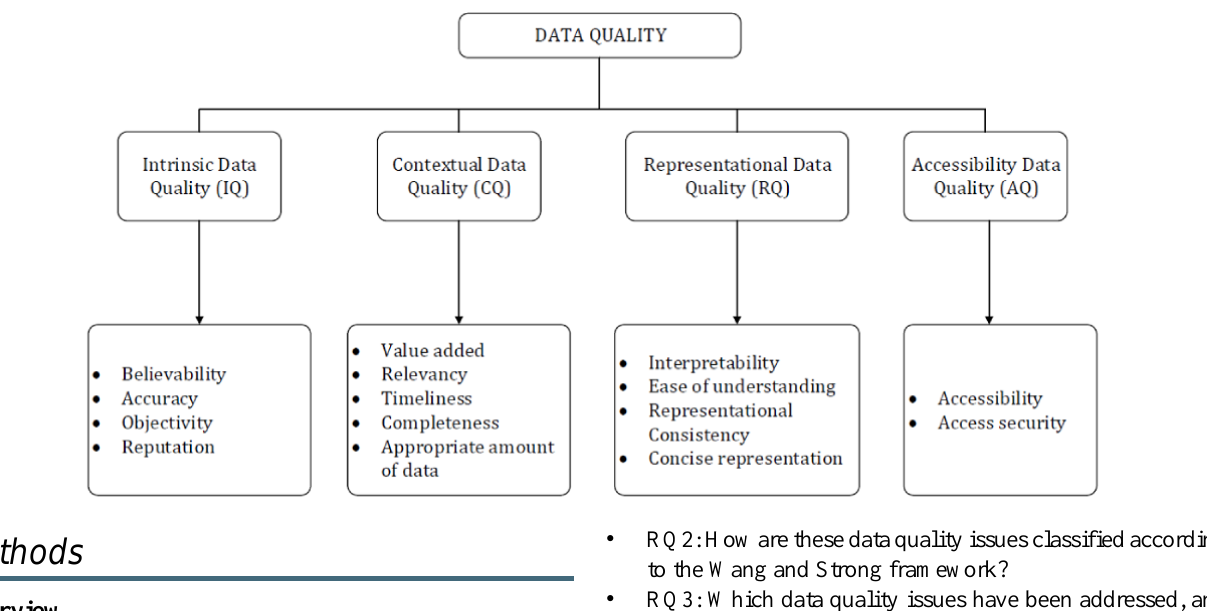
Figure 1. Data quality framework adapted from Wang and Strong [58].